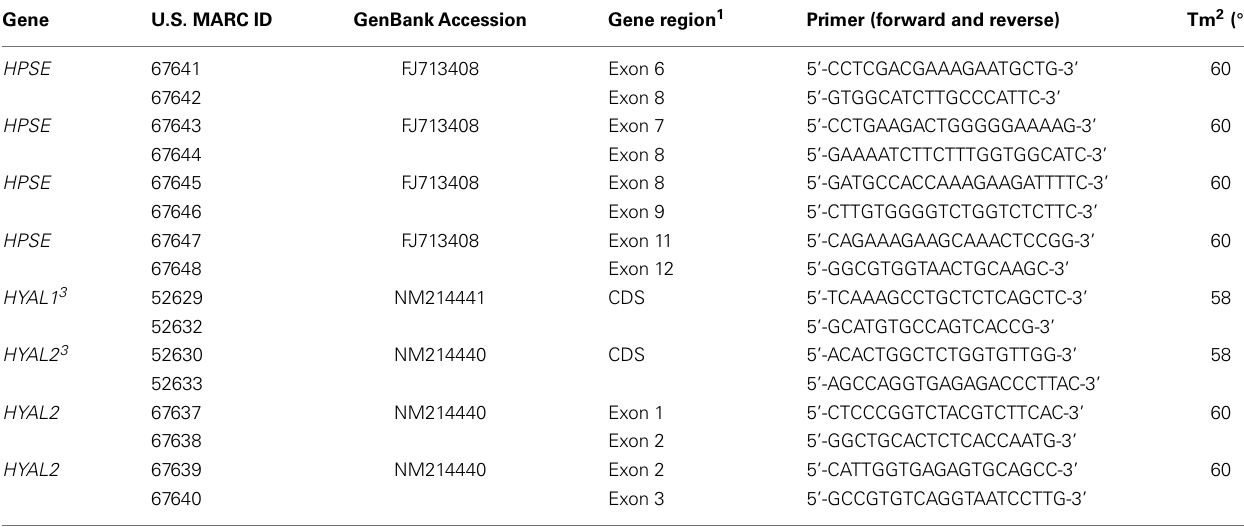
Table 1 | Amplification primers for sequencing HPSE , HYAL1 , and HYAL2 for SNP detection and identification.